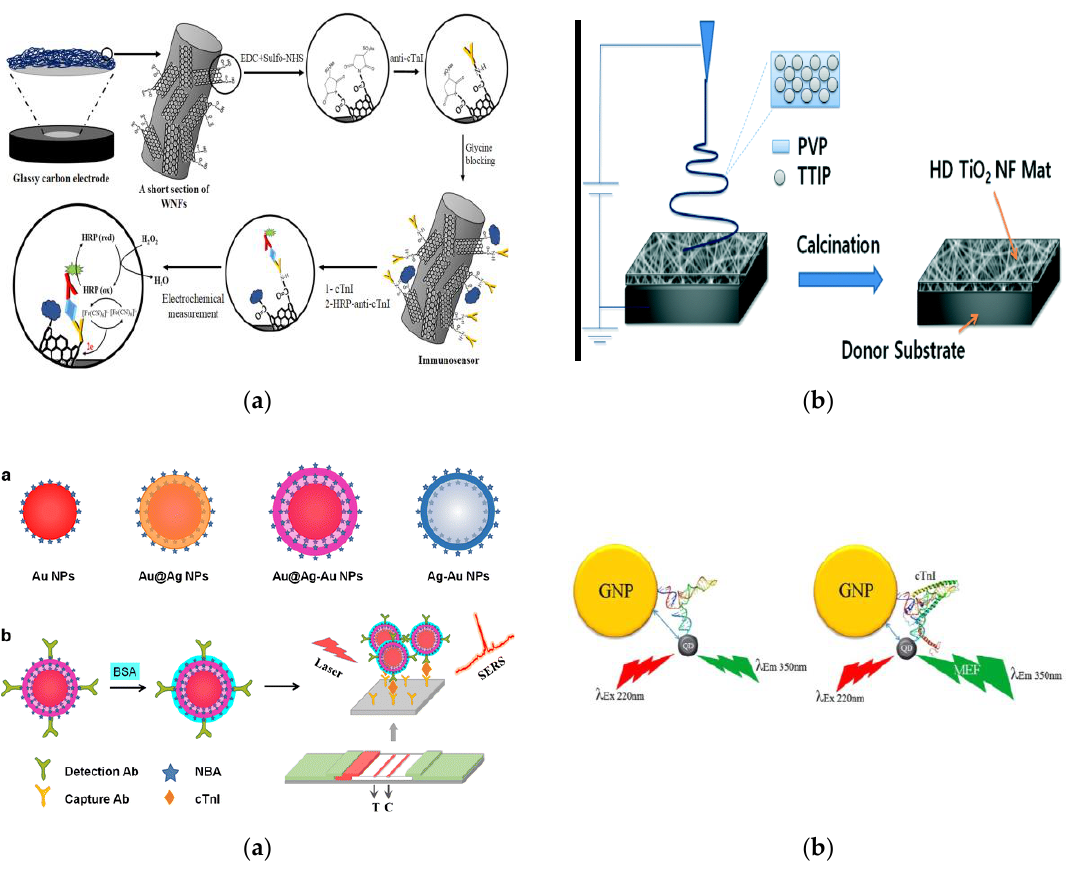
Figure 2. Using nanomaterials in cTnI sensor fabrication [88,92,93,96] ( a ) Electrode fabrication using carbon nanotube-whiskered nanofibers and the bioreceptor conjugation strategy; ( b ) Fabrication process of a nanofiber mat using electrospinning; ( c ) SERS nanoparticles for signal enhancement in a lateral flow assay; ( d ) Luminescence aptasensor detection mechanism showing the reduction in the distance between AuNP and QD enhancing the fluorescent signal (All figures have been re-printed with permission from the publisher).